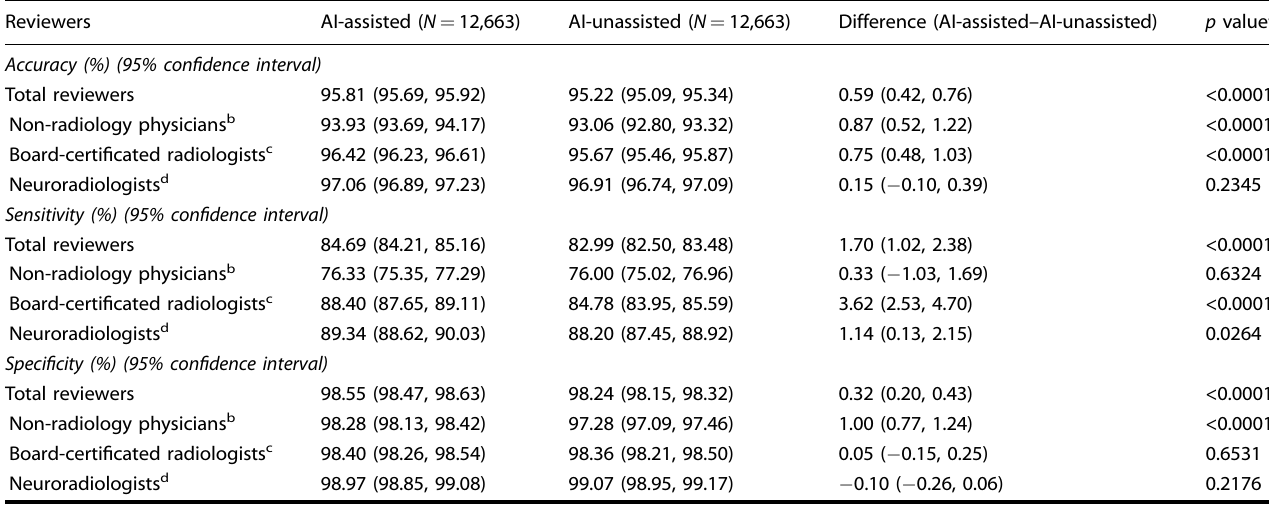
Table 3. Accuracy, sensitivity, and speci fi city of each subgroup after conducting AI-assisted or AI-unassisted evaluation in slice-wise analysis. Reviewers